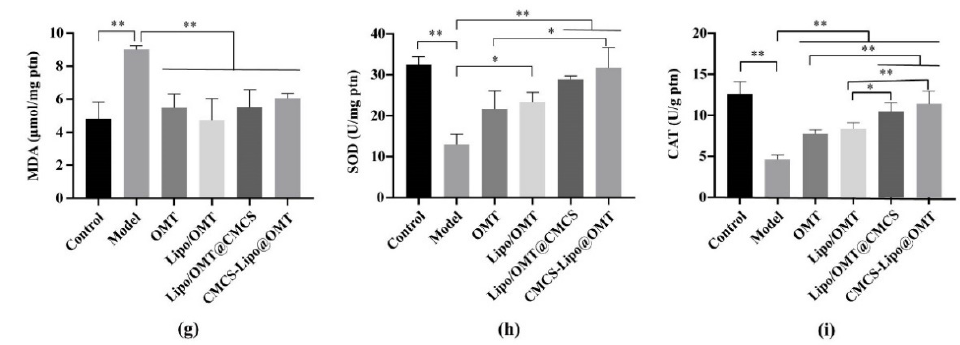
Figure 5. Effect of OMT and its liposomal preparations on the inflammation and oxidation stress in PPE-induced emphysema mice. The percentage of ( a ) macrophages, ( b ) neutrophils and ( c ) lympho- cytes in total leucocytes of BALF. The level of ( d ) TNF- α , ( e ) IL-1 β and ( f ) IL-6. The levels of ( g ) MDA, ( h ) SOD and ( i ) CAT. ( a – c ) Data represent the means ± SD ( n = 3).( d – i ) Data are expressed as mean ± SD ( n = 5). * p < 0.05, ** p < 0.01.